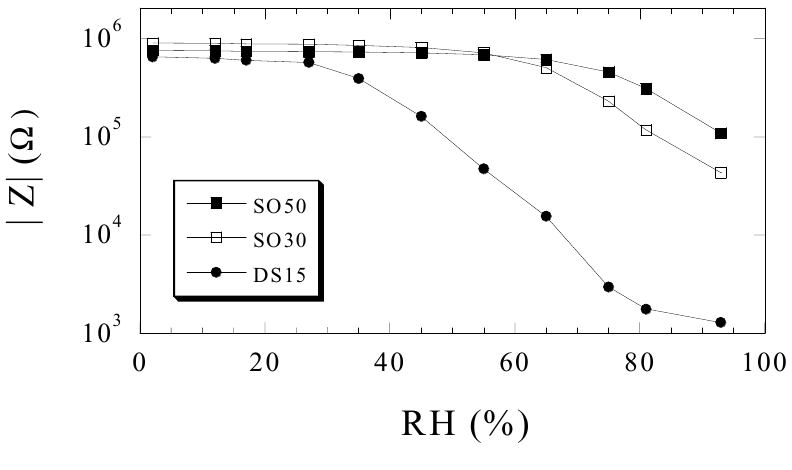
Figure 6. Impedance of sensors measured at 5 kHz over different humidity